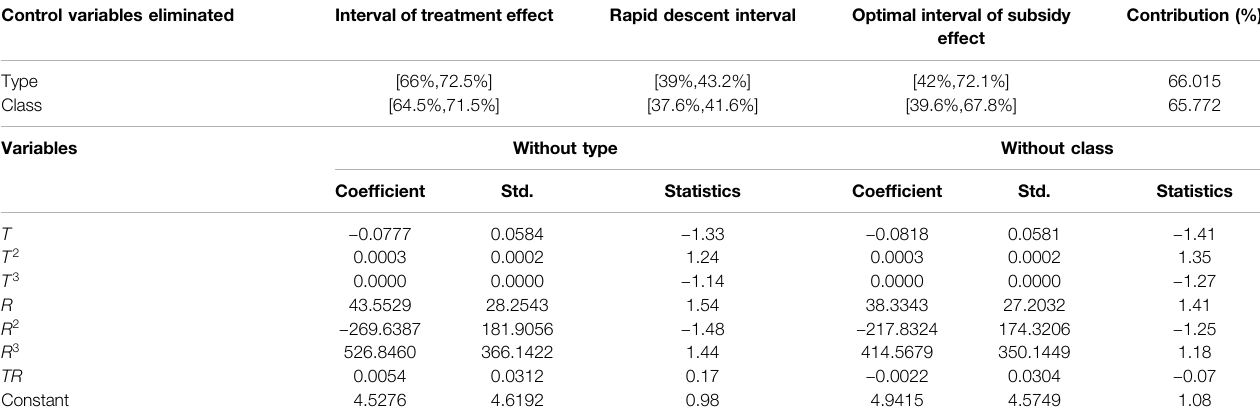
TABLE 9 | Sensitivity test of the model